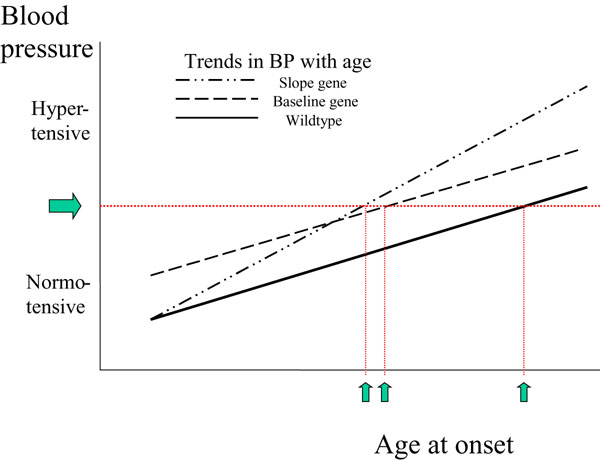
Relationship between age-at-onset and average BP measurements models